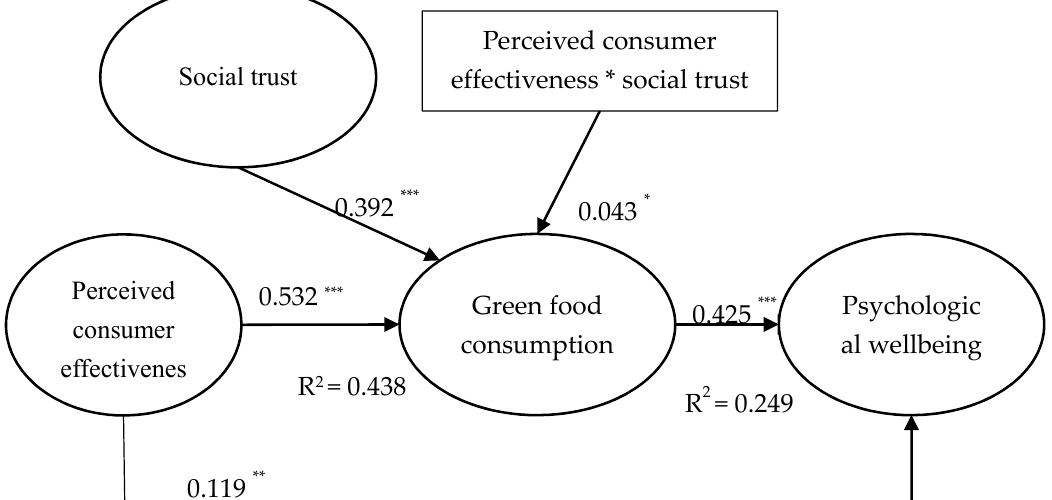
Figure 2. Results of hypothesis testing ( N = 514). * p < 0.05, ** p < 0.01, *** p < 0.001.